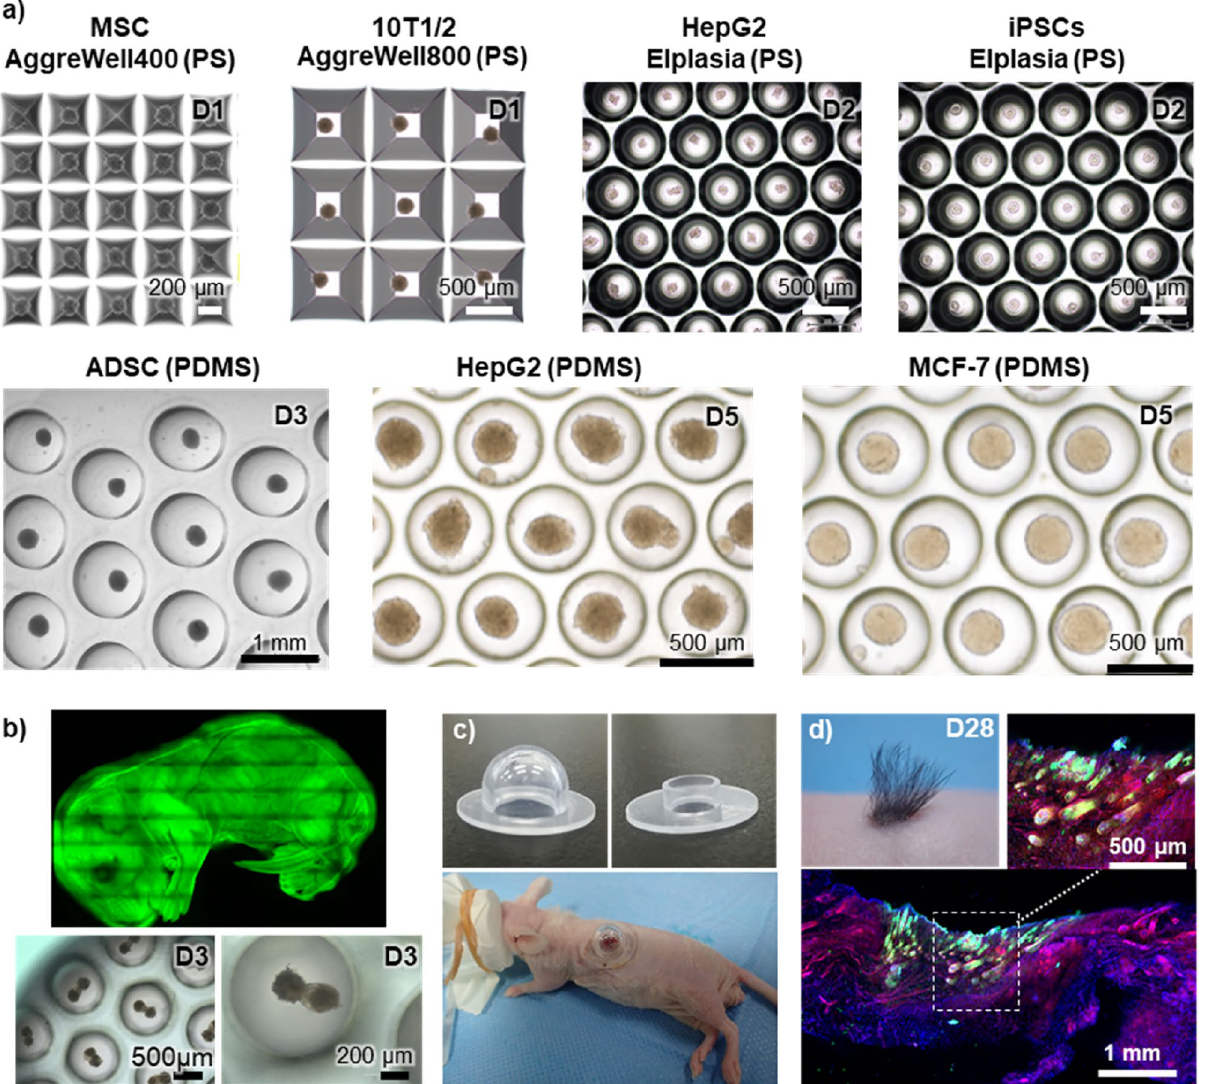
Figure 5. Aggregate formation of various cell types on prevelex-coated microwell array plates and hair follicle neogenesis upon transplantation of aggregates of GFP-labeled cells. ( a ) Spherical aggregate formation. PS and PDMS plates with square pyramid and hemispherical microwell arrays are coated with prevelex, and the cells indicated are seed and cultured for 1–5 days. ( b ) Transgenic fetus mice expressing green fluorescence protein (GFP) and hair follicle germ-like aggregates formed at three days of culture. Embryonic epithelial and mesenchymal cells are isolated from the fetus and let them form aggregates in the prevelex-coated PDMS microwell array plate. ( c ) Lab-made chambers for patch assay with nude mice. ( d ) Hair follicle neogenesis in vivo. The aggregates composed of the two cell types are transplanted into the dorsal skin of nude mice. Appearance of generated hair shafts is shown. The fluorescent images are from histological sectioning of the transplanted site. Rhodamine-phalloidin and DAPI staining were used to visualize actin cytoskeleton and nuclei of all the cells in the skin sections. GFP indicates cells from